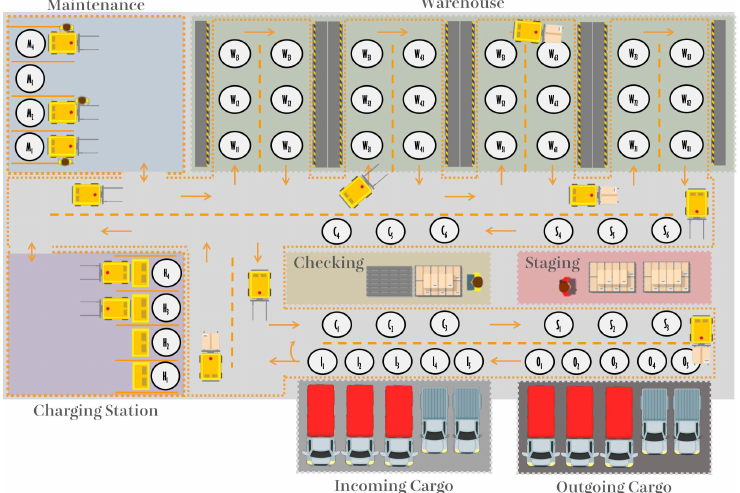
Figure 1. Floor plan of the warehouse logistics with the following sectors: Maintenance, Charging Station, Warehouse, Checking, Staging, Incoming Cargo, and Outgoing Cargo [42] (© 2020